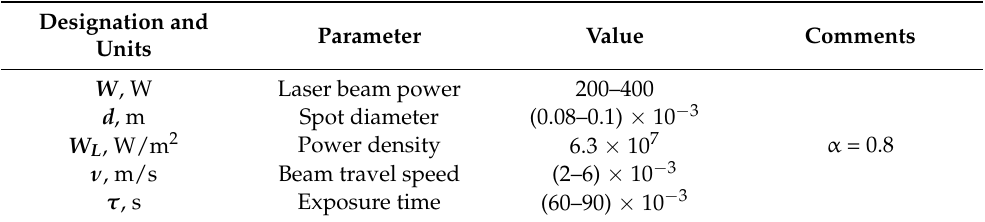
Table 4. Technological characteristics of printing process for gearbox